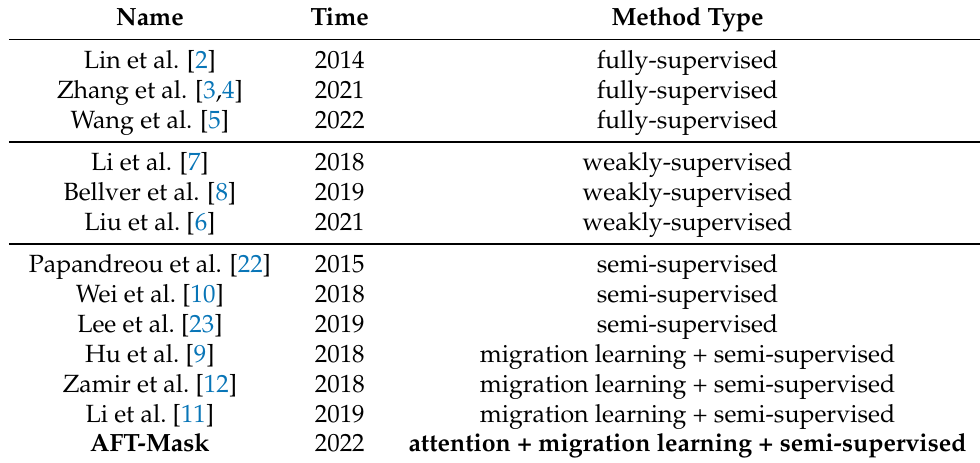
Table 1. Literature list of instance segmentation